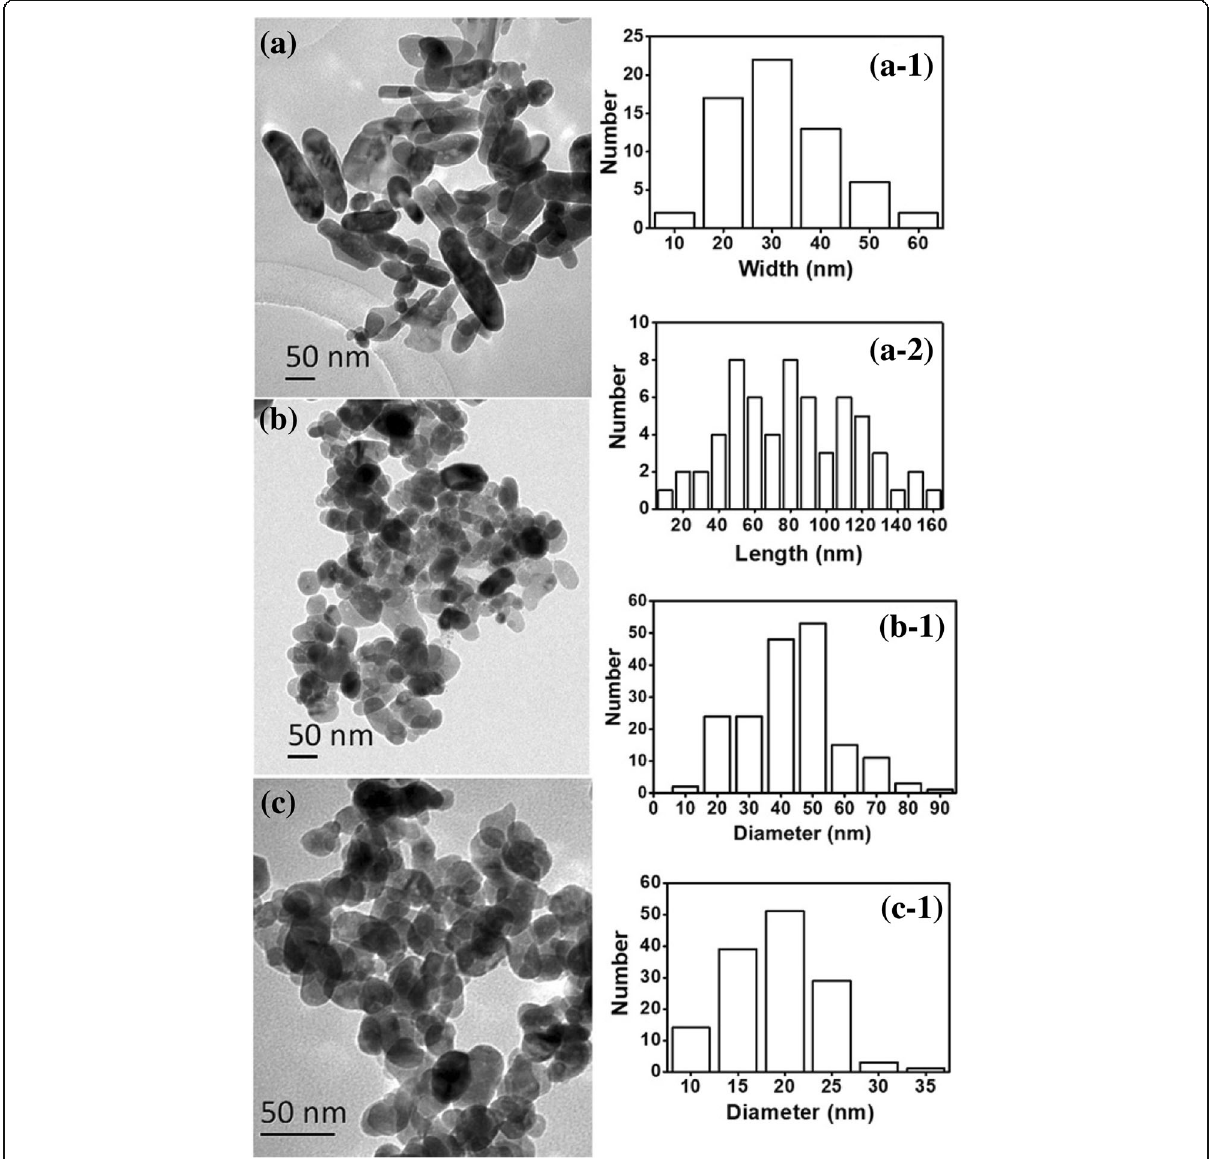
Fig. 3 TEM images of ZnO nanoparticles obtained from the different mole ratios of glycerol to Zn 2+ ( a , 0.33:1; b , 1:1; c , 3.33:1). a-1, a-2 corresponding histogram of ( a ) sample; b-1, c-1 corresponding histogram of ( b ) and ( c ) sample